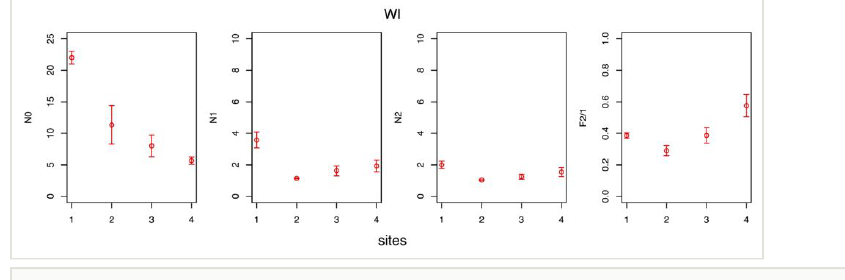
Variability of the observed species diversity and eveness along the sites (1, 2, 3, 4) transect during the winter (WI) survey. Diversity was measured using the Hill numbers N0, N1 and N2, whereas eveness was measured with the F2/1